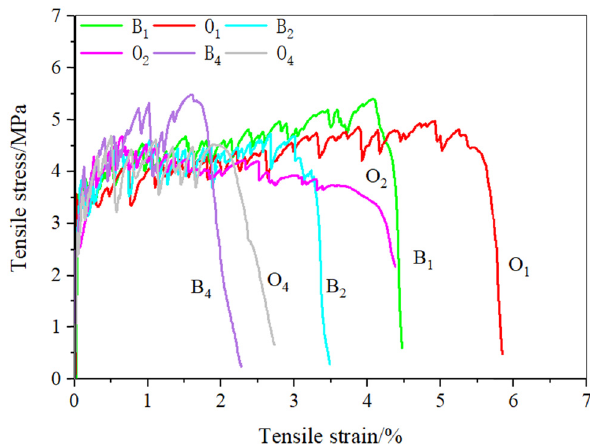
Figure 4: Tensile stress – strain curves of SHCC.